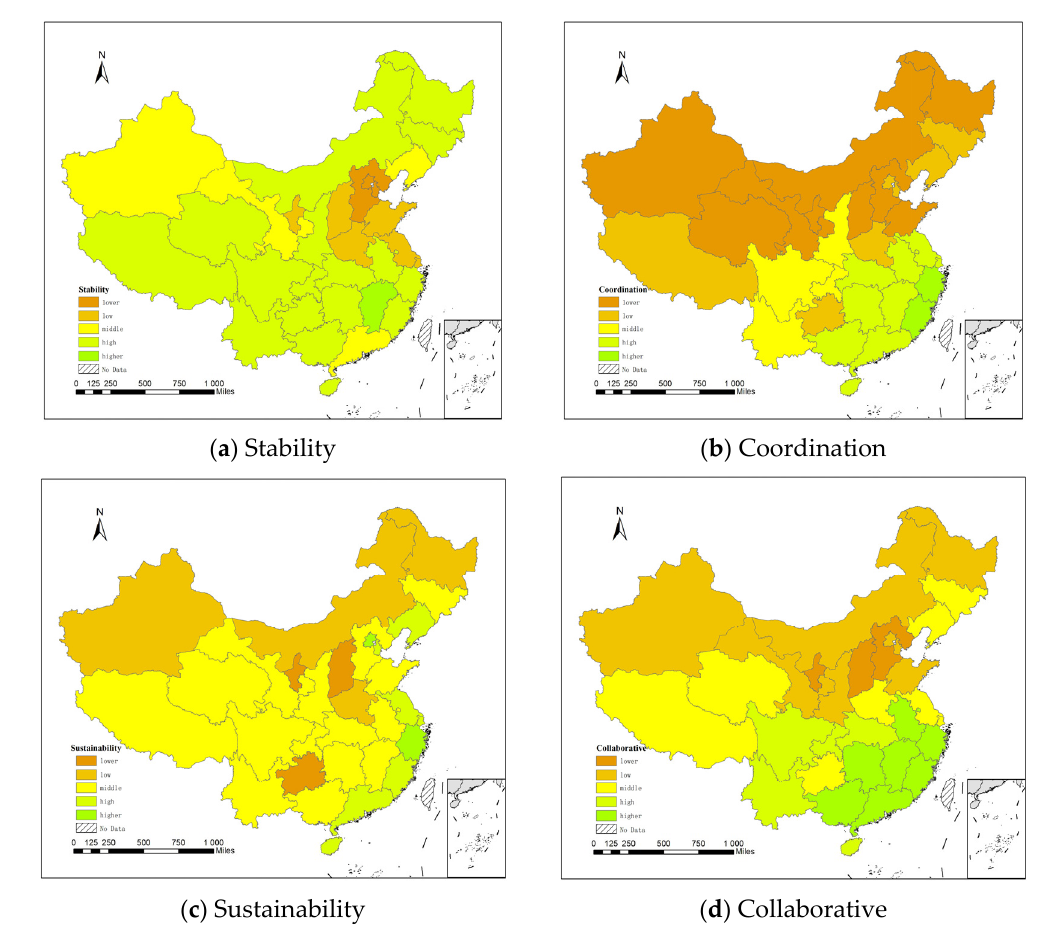
Figure 6. Spatial distribution of security index: ( a ) stability index; ( b ) coordination index; ( c ) sustainability index; ( d ) collaborative index.